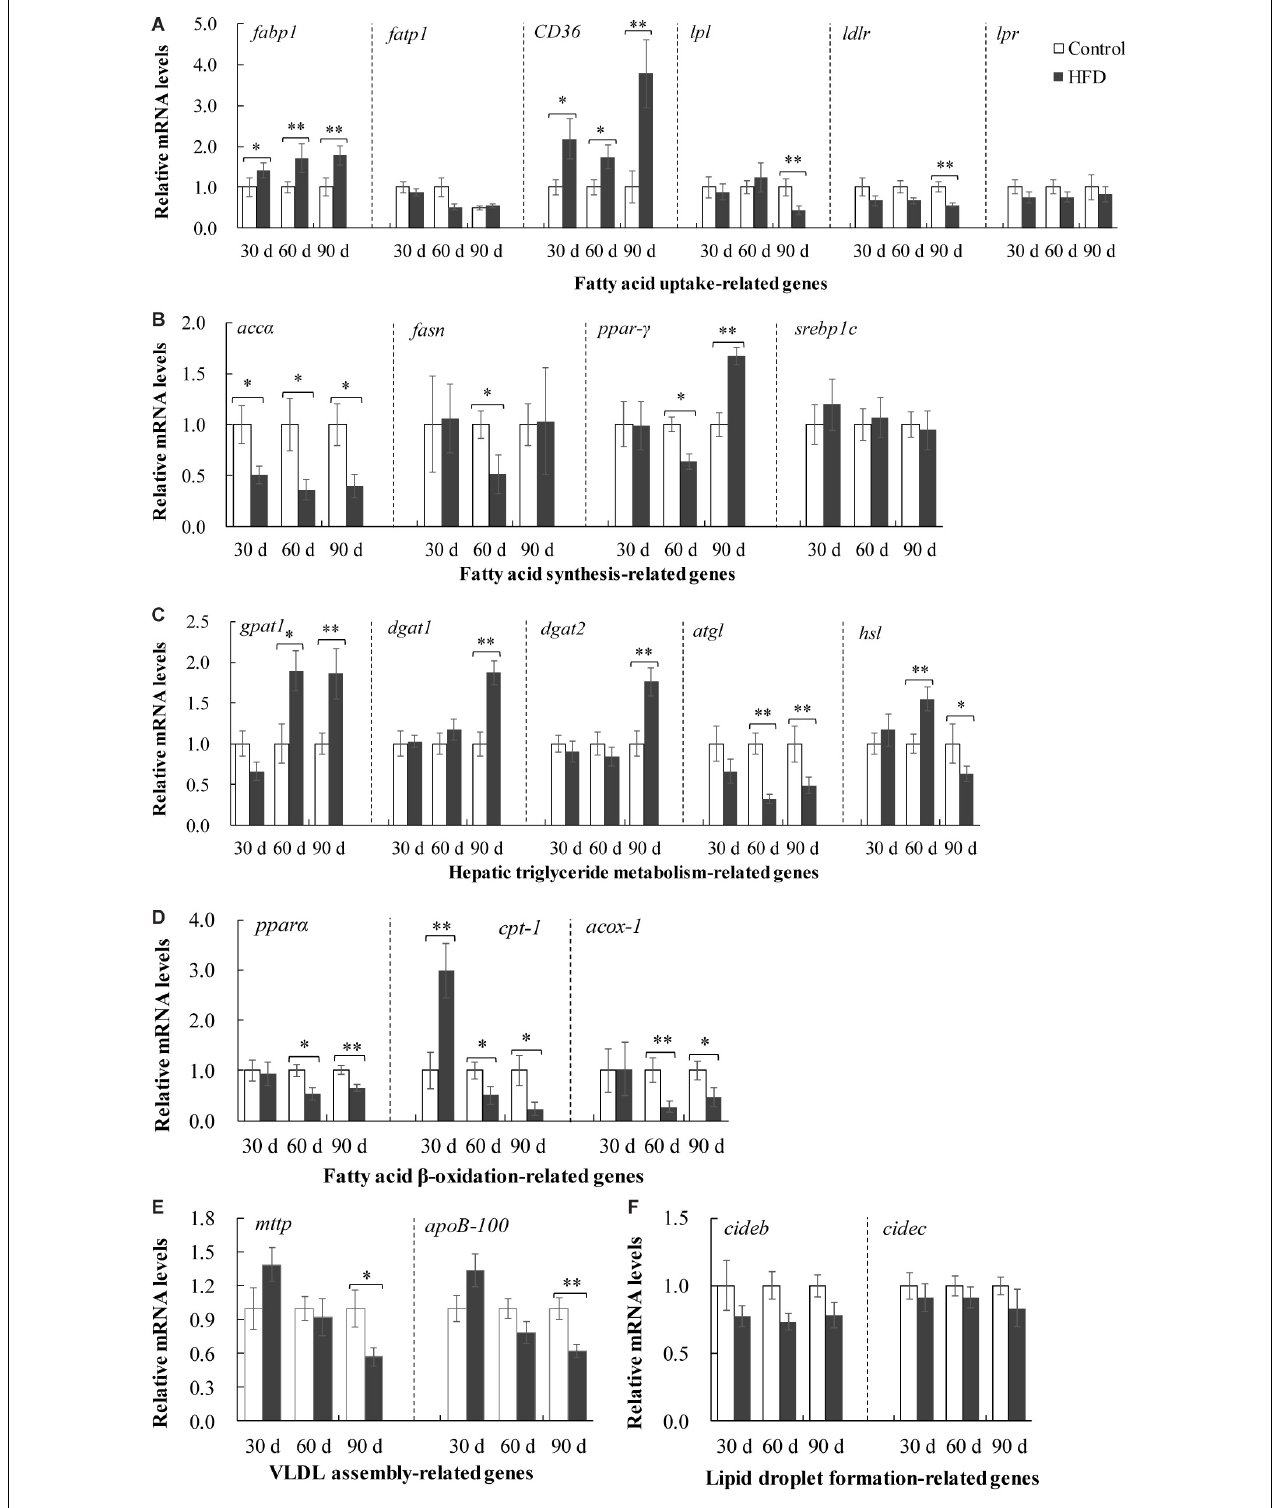
FIGURE 4 | Expression of fatty acids metilapia fed on control diet and HFD for 90 days. (A) Expression of fatty acid uptake-related genes including fabp1, fatp1, CD 36, lpl, ldlr and lpr ; (B) expression of fatty acid synthesis-related genes including acc α , fasn , ppar- γ and srebp1c ; (C) expression of hepatic triglyceride metabolism-related genes including gpat1 , dgat1 , dgat2 , atgl and hsl ; (D) expression of fatty acid β -oxidation-related genes including ppar α , cpt-1 and acox-1 ; (E) expression of VLDL assembly-related genes including mttp and ApoB100 ; (F) expression of lipid droplet formation-related genes including cideb and cidec . The values are normalized to control values and expressed as means ± SEM ( n = 10); ∗ P < 0.05 and ∗∗ P < 0.01 versus control at same time.